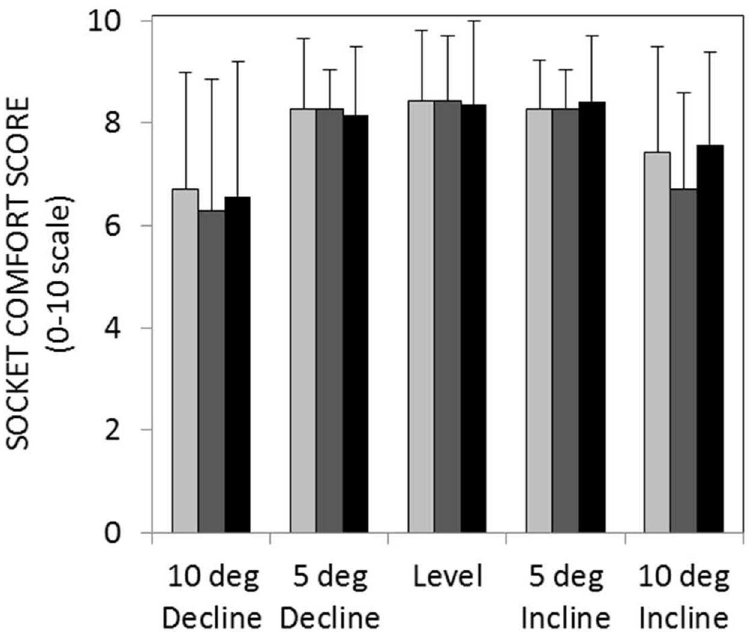
Fig 8. Mean socket comfort score (+ 1 standard deviation) across sloped walking conditions (RIGID = light gray, MULTI = gray, HYDRA = black). This 11-pointscale rangesfrom 0 (worst comfort imaginable) to 10 (greatest comfort